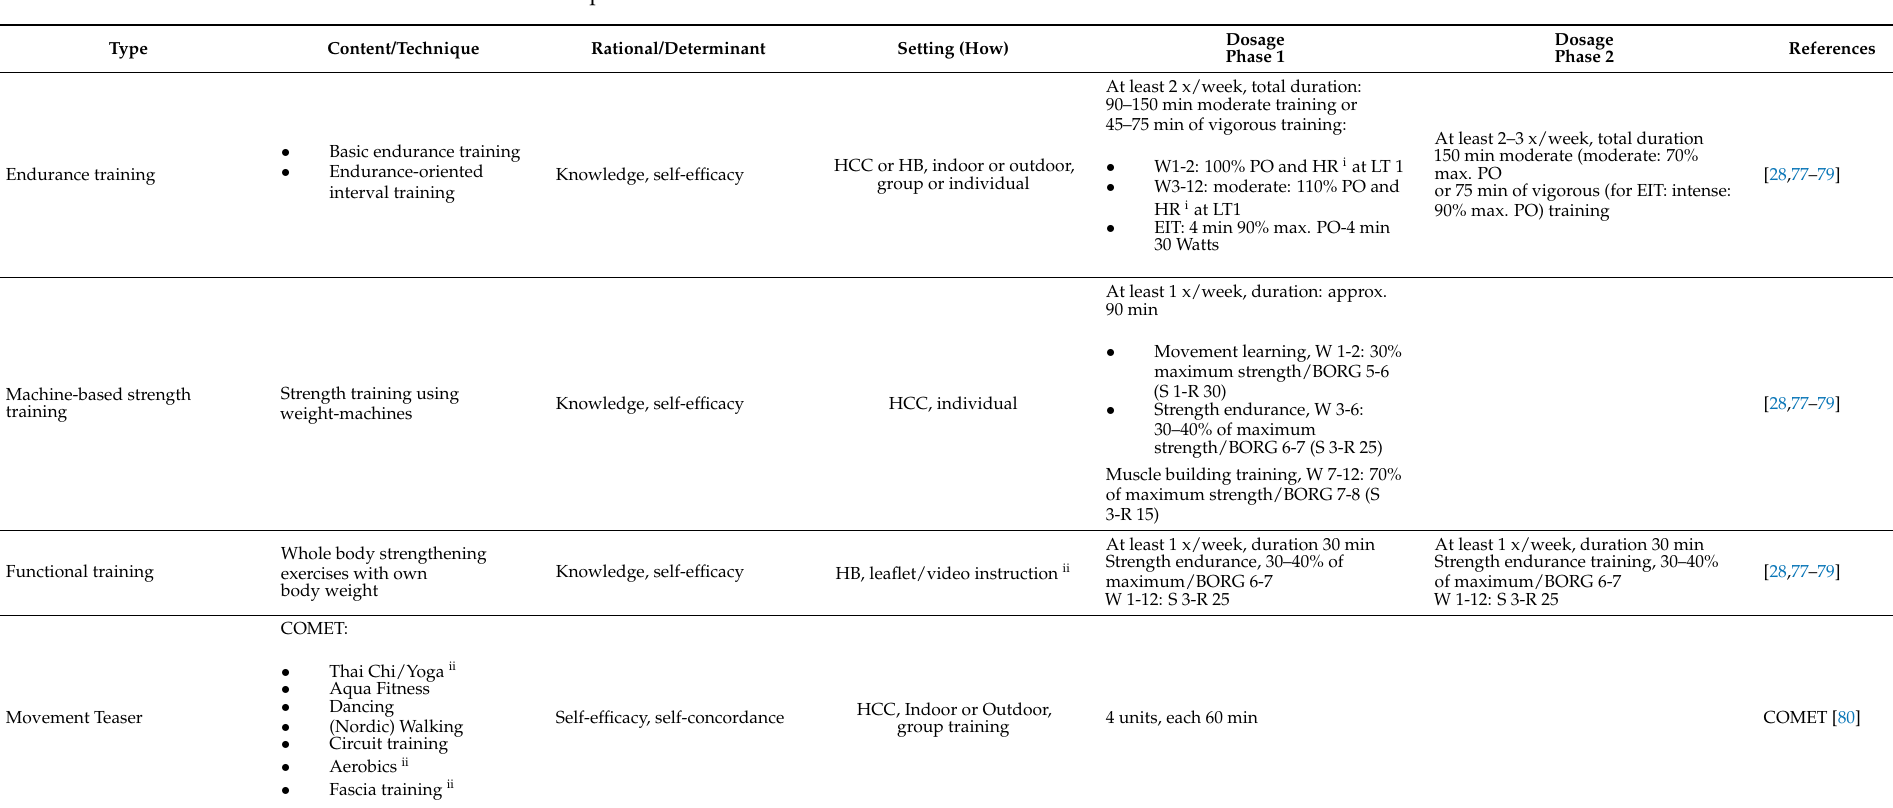
Table A1. Intervention components